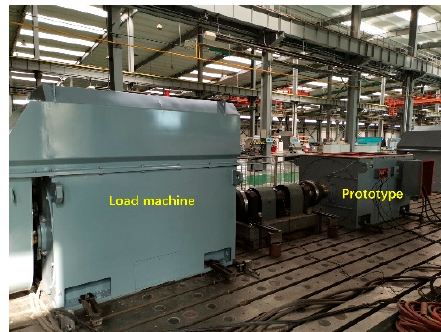
Figure 24. Experimental test.